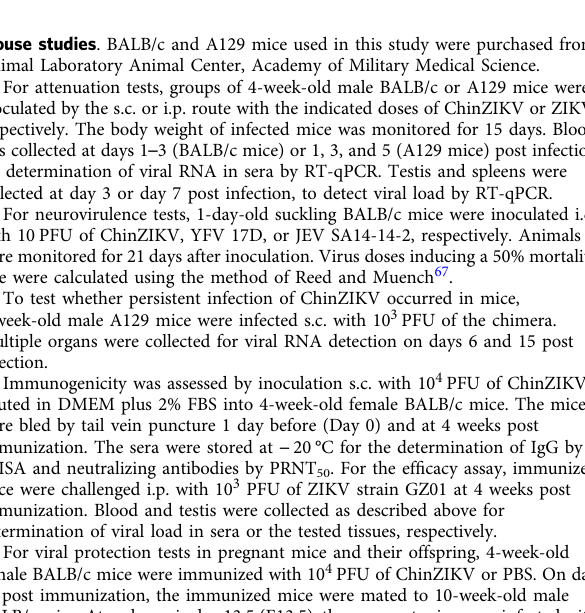
Table 2. The 20 μ l reaction mixtures were set up with 2 μ l of RNA. Cycling con- ditions were as follows: 42 °C for 5min, 95 °C for 10s, followed by 40 cycles of 95° C for 5 s and 60°C for 20